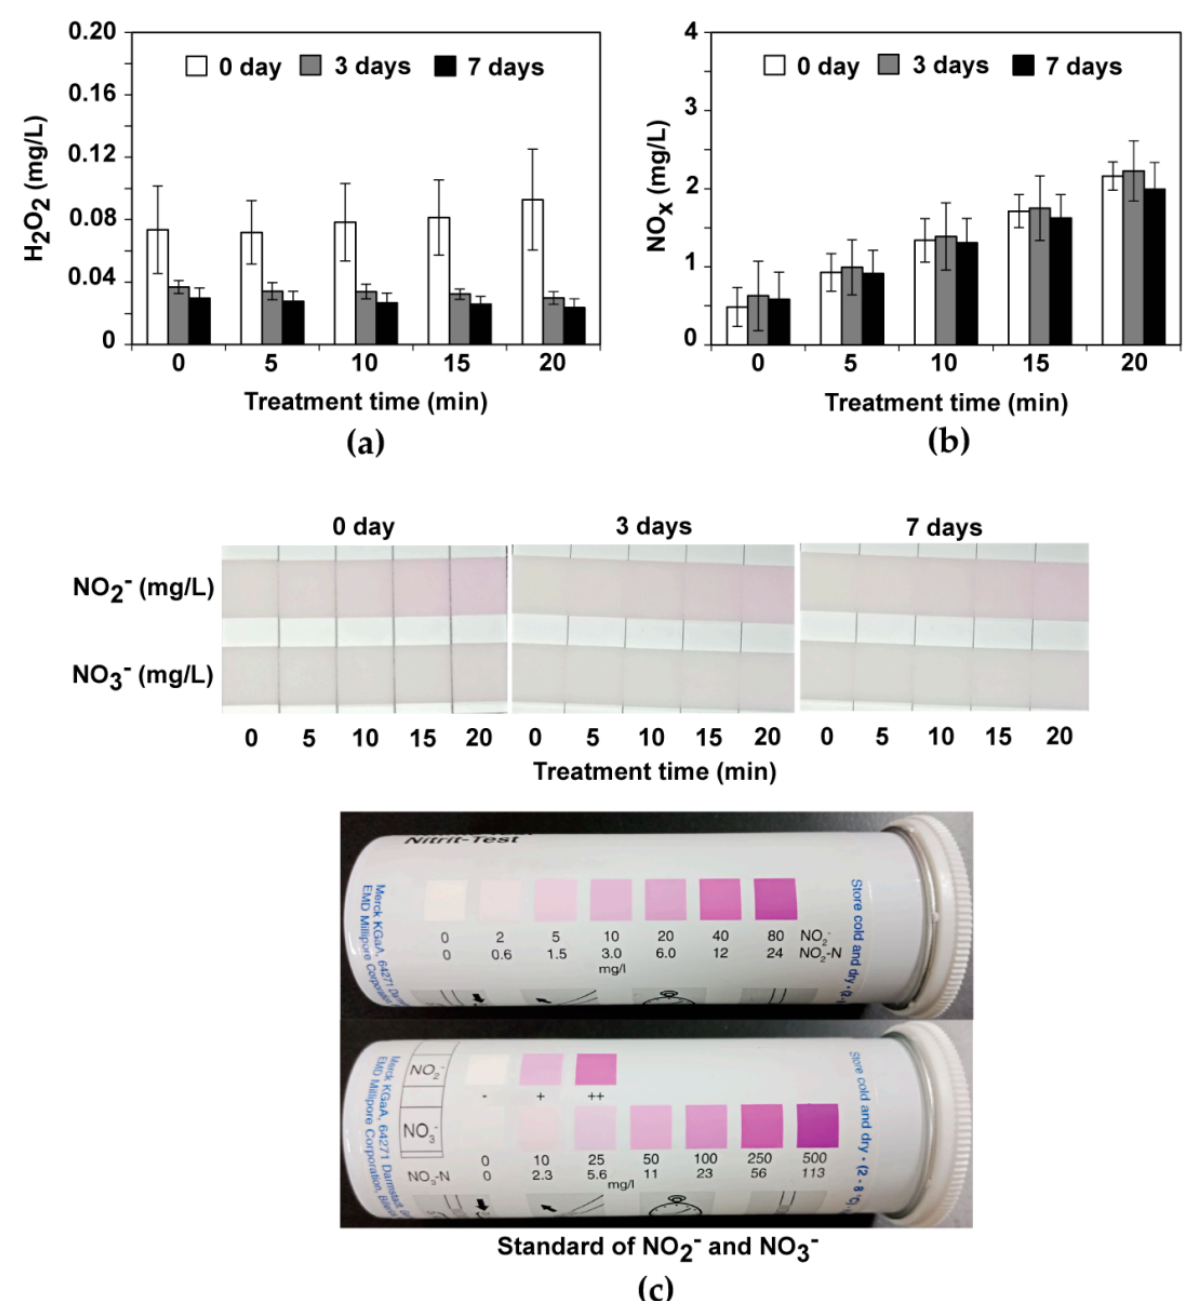
Figure 4. Evaluation of the reactive oxygen and nitrogen species (RONS) level in the PDB solution post plasma treatment for 5, 10, 15, and 20 min, or without treatment (0 min = control). Following plasma treatment, the PDB was incubated for 0, 3, and 7 days. ( a ) Concentration of H 2 O 2 . ( b ) Concentration of NO X . ( c ) Color change in the NO 2 − and NO 3 − strips after soaking in the control and plasma-treated PDB (upper panel), as well as the standard concentrations of NO 2 − and NO 3 − according to the color of the strips (bottom panel). In ( a , b ), each value is indicated as the mean and standard deviation of 6 replicate